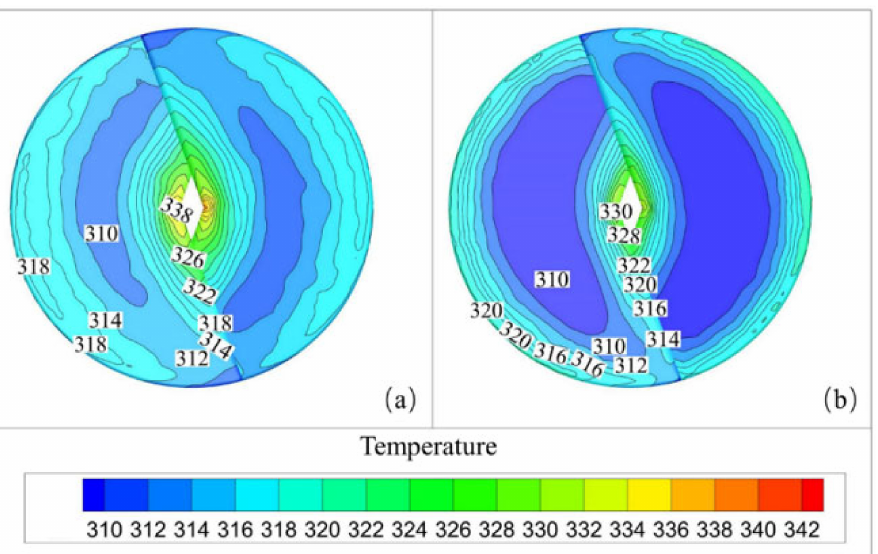
Figure 14. Temperature distribution under different electric conductivity rates: ( a ) 3.6 × 10 5 S/m and ( b ) 5.76 × 10 6